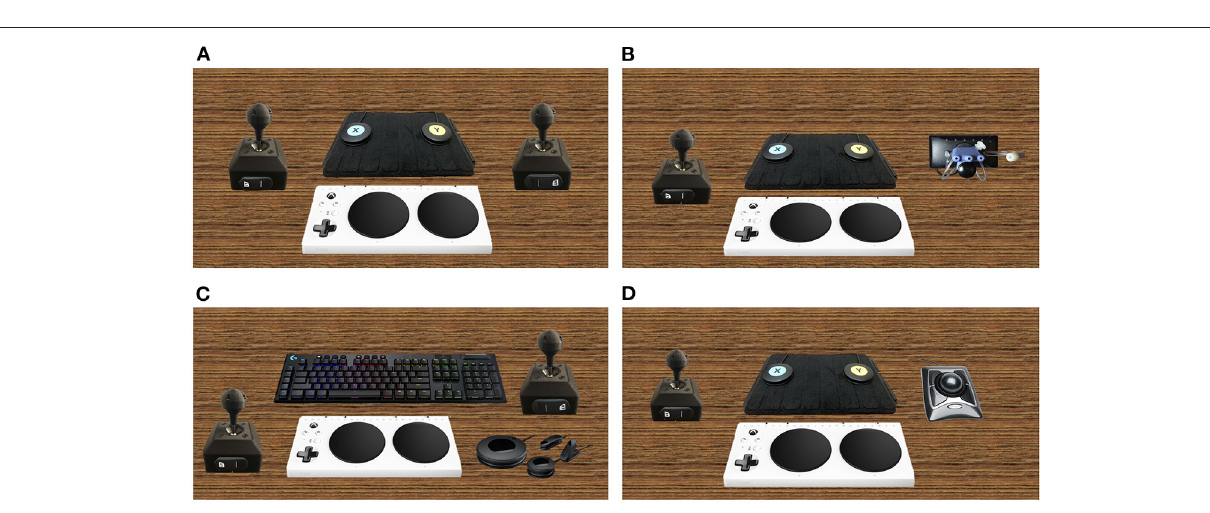
FIGURE 3 | Ideal or planned gaming setups. (A) Ideal setup of P2 and P7. This setup includes the adaptive Xbox controller, the Logitech Adaptive Gaming Kit, and two joysticks from Warfighter Engaged with an analog switch from the Adaptive Gaming Kit on the base of each joystick. (B) P3’s ideal gaming setup. This setup includes the adaptive Xbox controller, the Logitech Adaptive Gaming Kit, one joystick from Warfighter Engaged with an analog switch from the Adaptive Gaming Kit on the base, and one QuadStick. (C) P4’s current gaming setup. This setup includes a combination of the Xbox Adaptive controller, the Logitech Adaptive Gaming Kit, one joystick from Warfighter Engaged, and the Logitech keyboard (D) P5’s ideal gaming setup. This setup includes the adaptive Xbox controller, the Logitech Adaptive Gaming Kit, a Warfighter Engaged joystick with an analog switch from the Adaptive Gaming Kit on the base, and a trackball